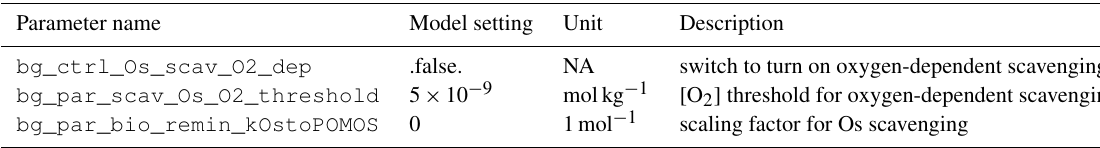
Table E4. Model parameters setting Os